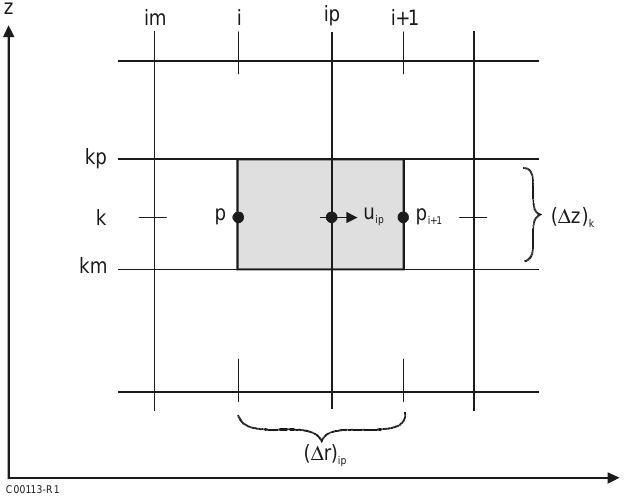
Fig. 1. Control volume for the calculation of partial densities across the ip face.